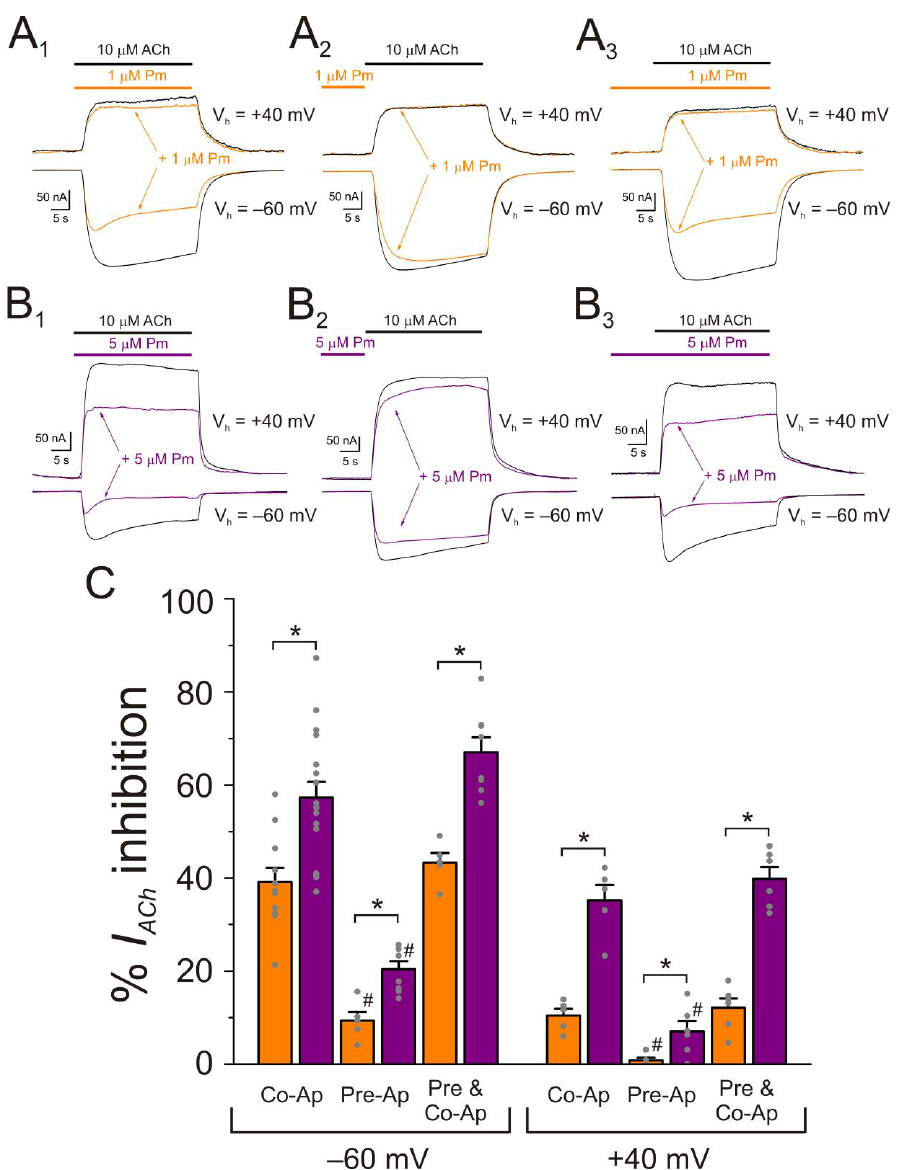
Fig.8 Figure 8. Effect of Pm-application timing and holding potential on nAChR blockade. ( A 1 – A 3 ) I ACh s elicited at − 60 mV (downward deflections) and at +40 mV (upward deflections) by co-application of 10 µ M ACh and 1 µ M Pm ( A 1 ), solely Pm pre-application before superfusing the agonist ( A 2 ) or Pm pre-application followed by its co-application with ACh ( A 3 ). ( B 1 – B 3 ) As in panels ( A 1 – A 3 ), but in the presence of 5 µ M Pm instead of 1 µ M. ( C ) Column graph shows the percentages of I p inhibition by Pm when applied as indicated in panels ( A 1 – A 3 , B 1 – B 3 ), at − 60 mV (on the left) and +40 mV (on the right). (*) indicates significant differences between I p inhibition elicited by 1 and 5 µ M Pm ( p < 0.05, t -test). (#) denotes significant differences, for each Pm concentration, among the percentages of I p inhibition elicited by ACh and Pm co-application and other Pm-application protocols, at the same holding potential ( p < 0.05, ANOVA and Bonferroni t -test). Each column is the average of 5–11 and 5–17 oocytes, for − 60 mV and +40 mV,